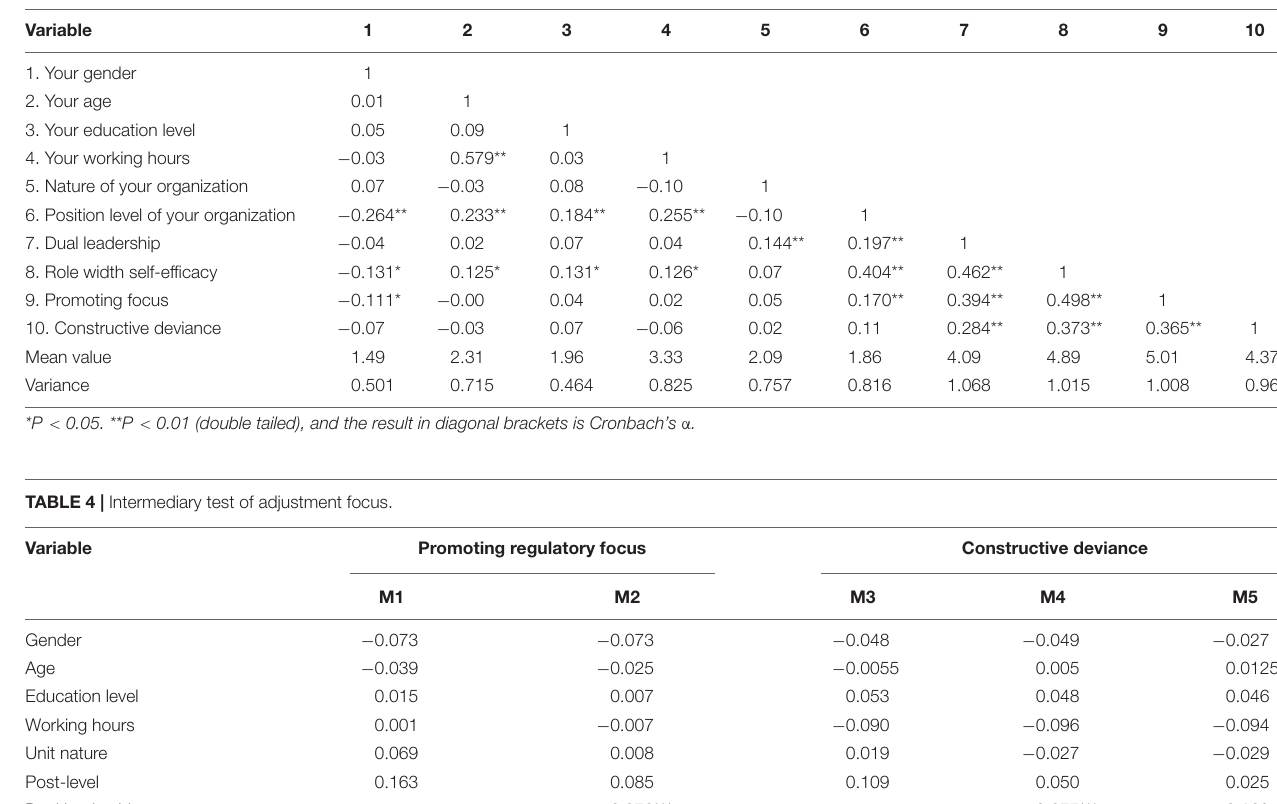
TABLE 3 | Correlation analysis results of research variables ( n = 333).